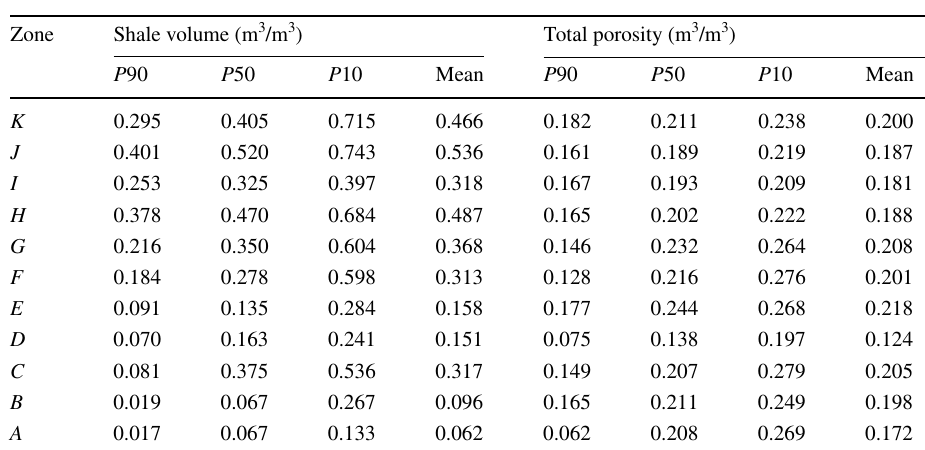
Table 3 Statistics of shale volume and total porosity